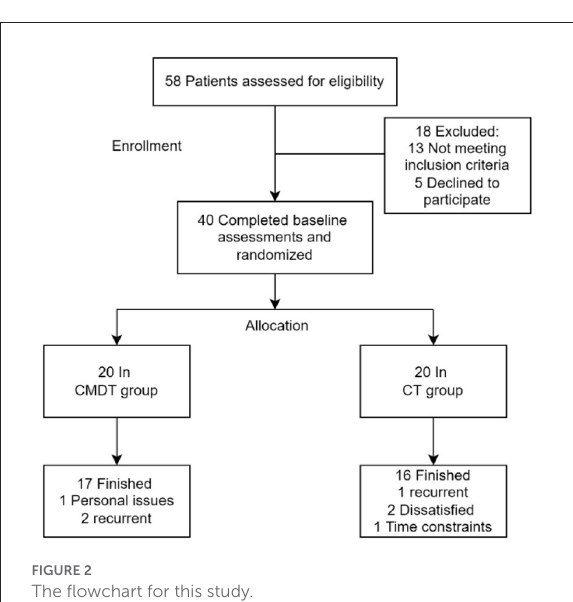
FIGURE2 The flowchart for this